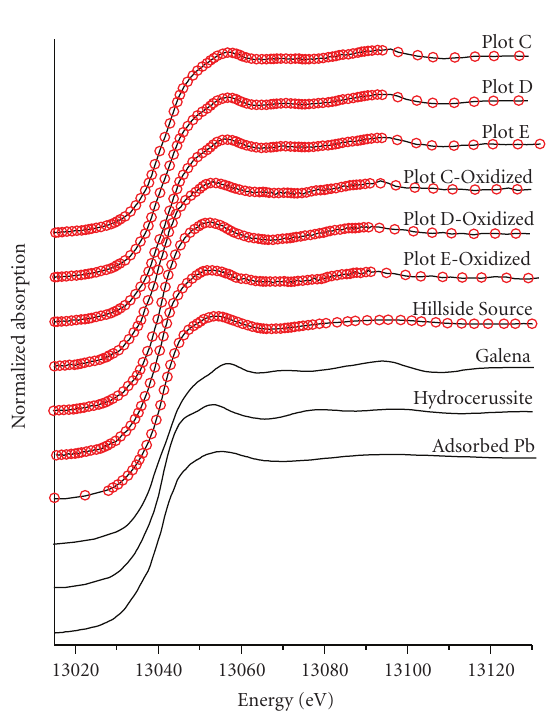
Figure 2: XANES spectra and LCF of postamendment Chopawam- sic Creek sediment. Plots C–E samples were collected from the top 5–8cm profile and stored under anaerobic conditions. Plots C–E- Top layer samples were collected from the top 0.5 cm profile and stored under anaerobic conditions. Plot C was amended with 1.5% phosphorus, Plot D was unamended, and Plot E was amended with 3% phosphorus. LCF of the spectra are shown as red circles and Pb standards used in the fits are shown for